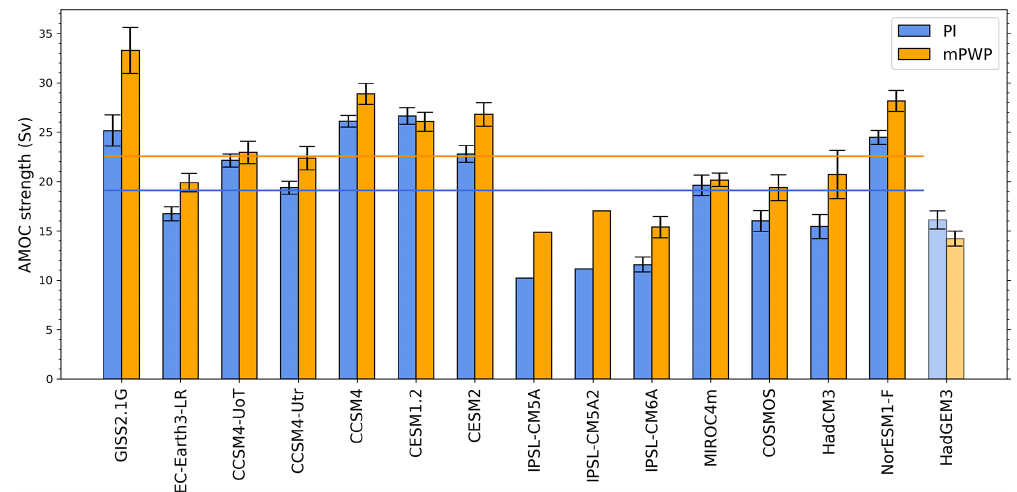
Figure 1. Individual model AMOC strength in the pre-industrial (blue) and mid-Pliocene (orange). Error bars indicate 1 standard deviation from the time-mean AMOC strength computed using 100 years of annual data. The horizontal lines indicate the multi-model mean AMOC strength.